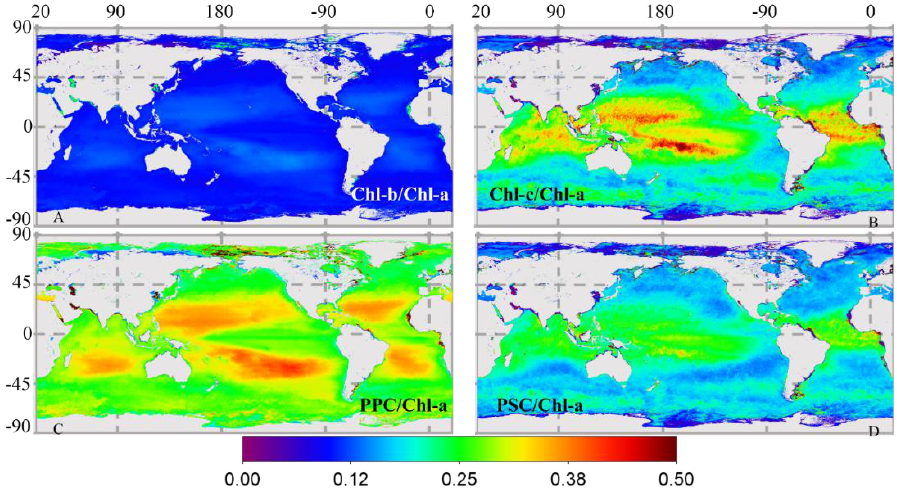
Figure 8. Global distributions of chlorophyll b (Chl-a), chlorophyll c (Chl-c), photoprotective carotenoids (PPC) and photosynthetic carotenoids (PSC) from 2007 L3 annual MERIS R rs ( λ ) imagery.